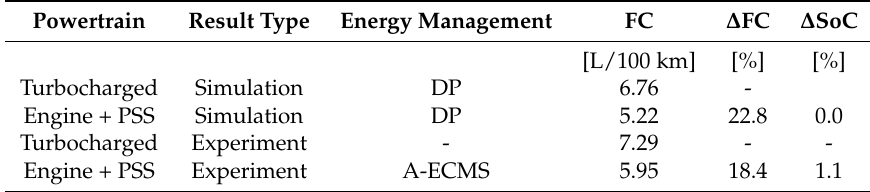
Table 1. Drive cycle fuel consumption results for Ford Escape